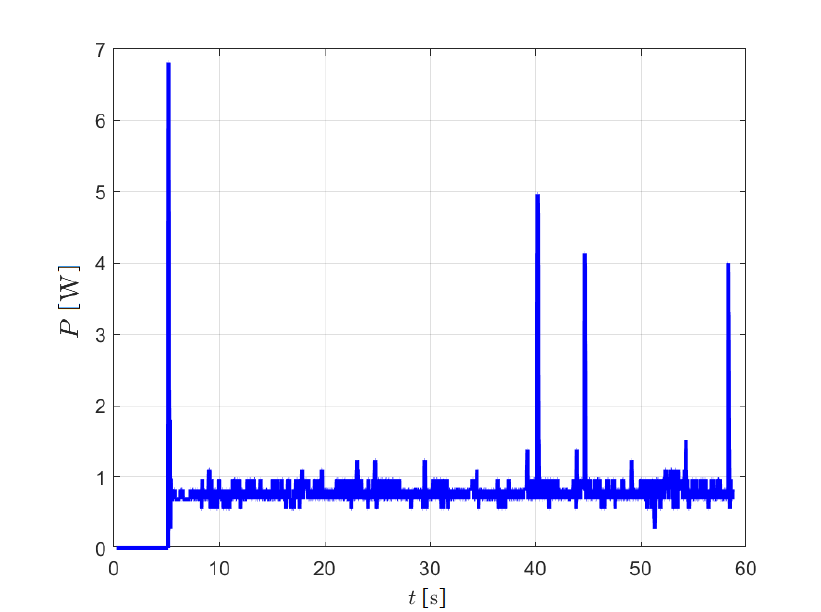
Figure 38. Power P during Map 1 run for the HybridA star algorithm of the